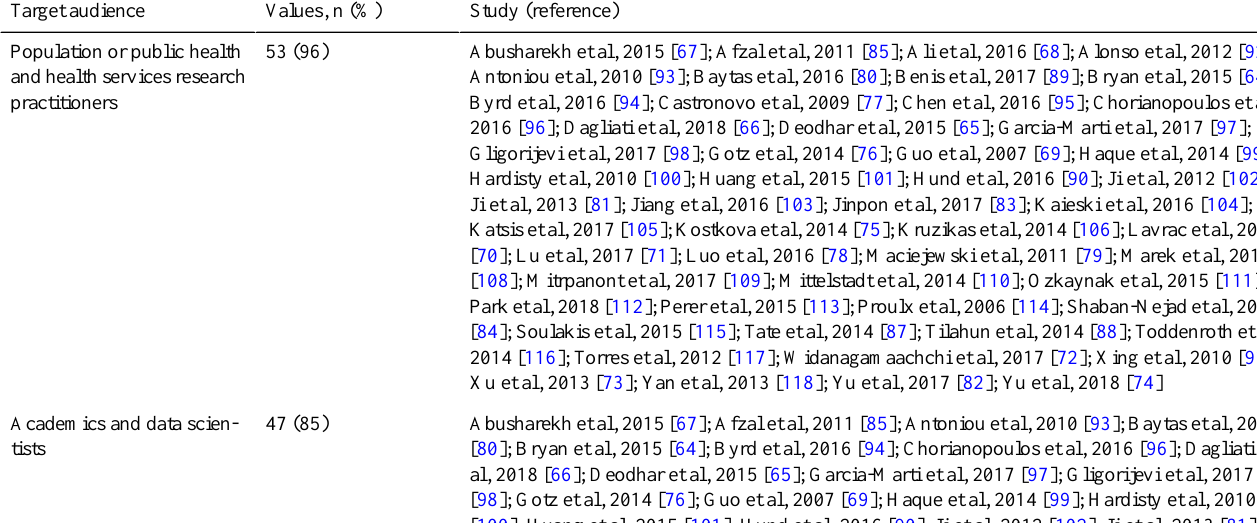
Study (reference)Values, n (%)Target